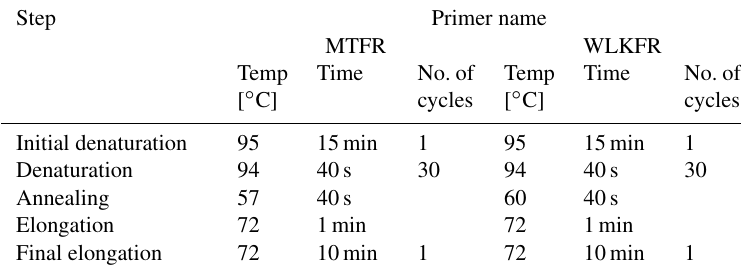
Step Primer name MTFR WLKFR Temp Time No. of Temp Time No. of [ ◦ C] cycles [ ◦ C] cycles Initial denaturation 95 15min 1 95 15min